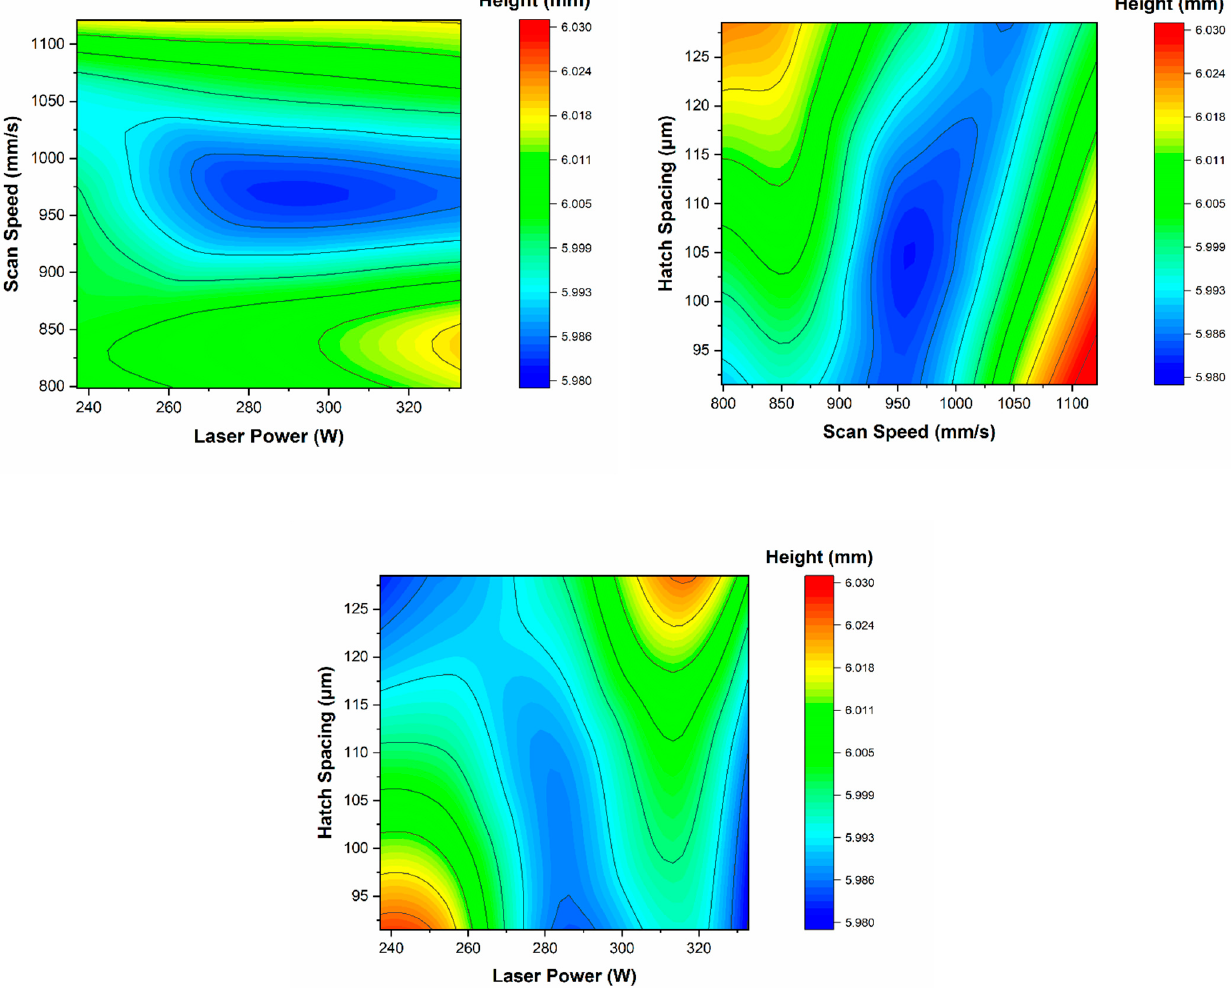
Figure 2. The influence of processing parameters on the height of the SLM ‐ fabricated IN718 samples.